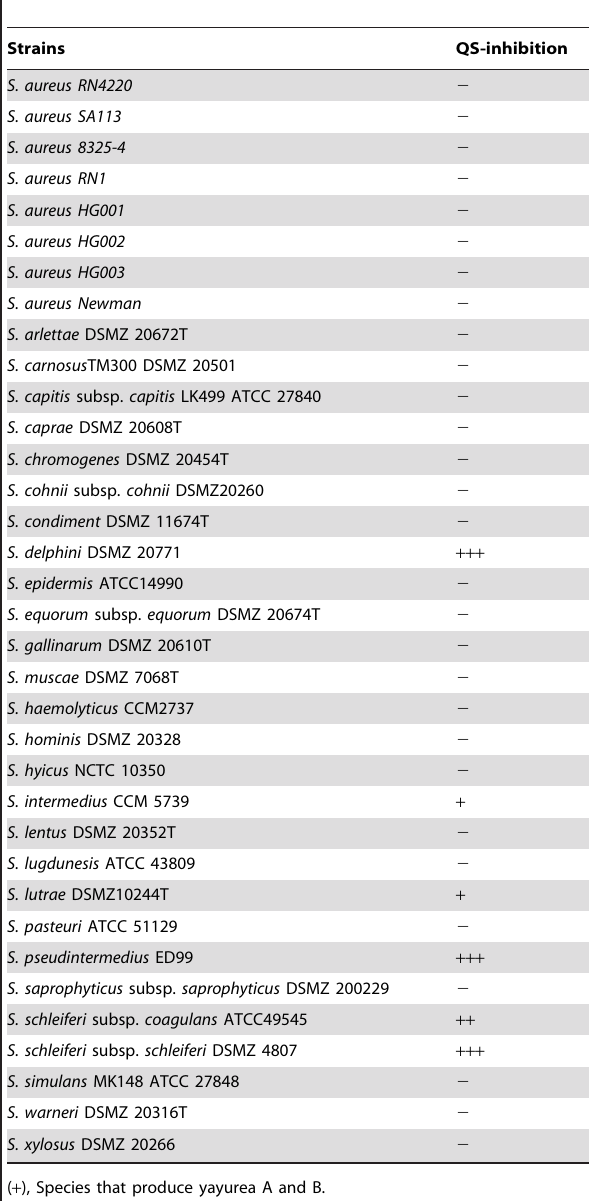
Table 2. Strains tested for Q-quenching activity and yayurea A and B